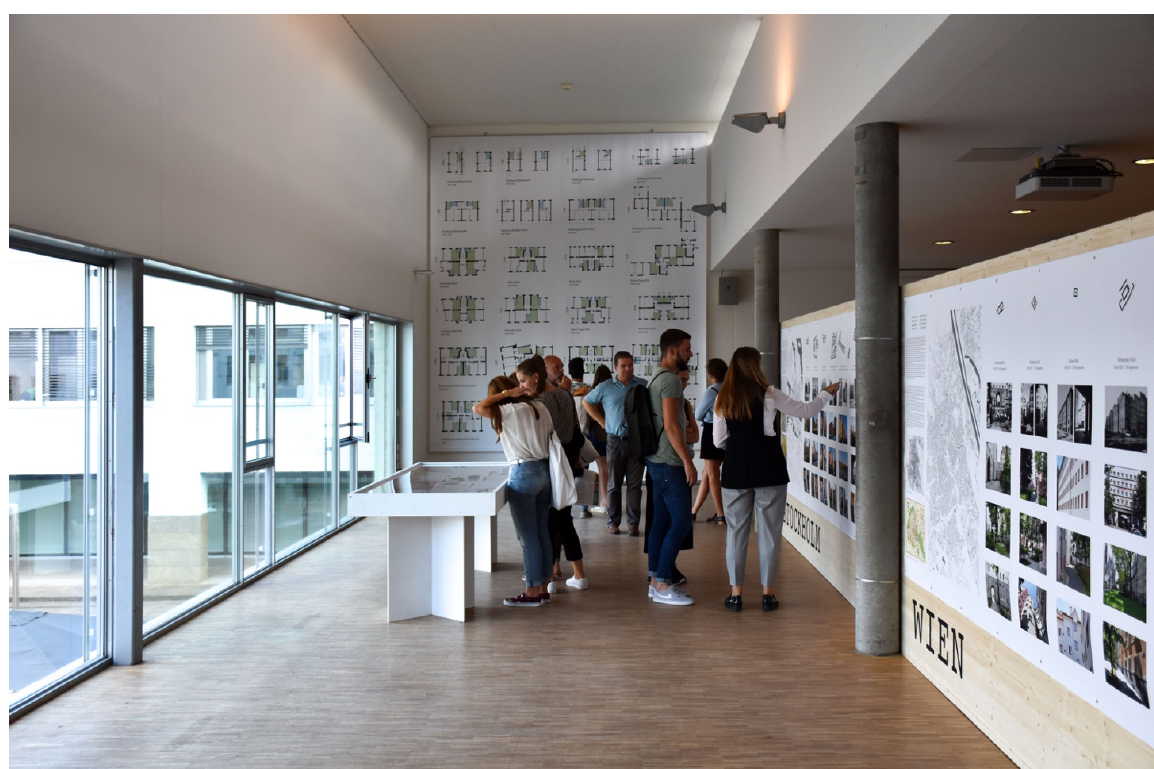
Figure 9. Third section: panel of the twenty-four dwelling units in the background. Source: Authors. serve the differences in terms of dwelling depth (e.g., 7–10 meters for Frankfurt, 9.50–12 meters for Vienna and 12.40–15 meters for Stockholm) as well as the loca- tion and size of the kitchen and